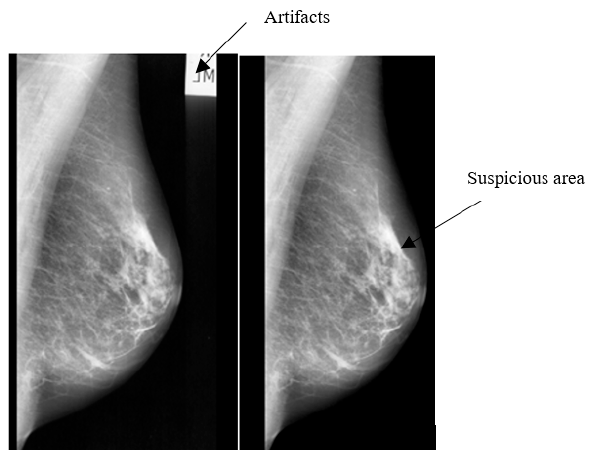
Figure 3. ( a ) Original enhanced abnormal mass case extracted from MIAS dataset [13] and ( b ) Suppressed image from artifacts.